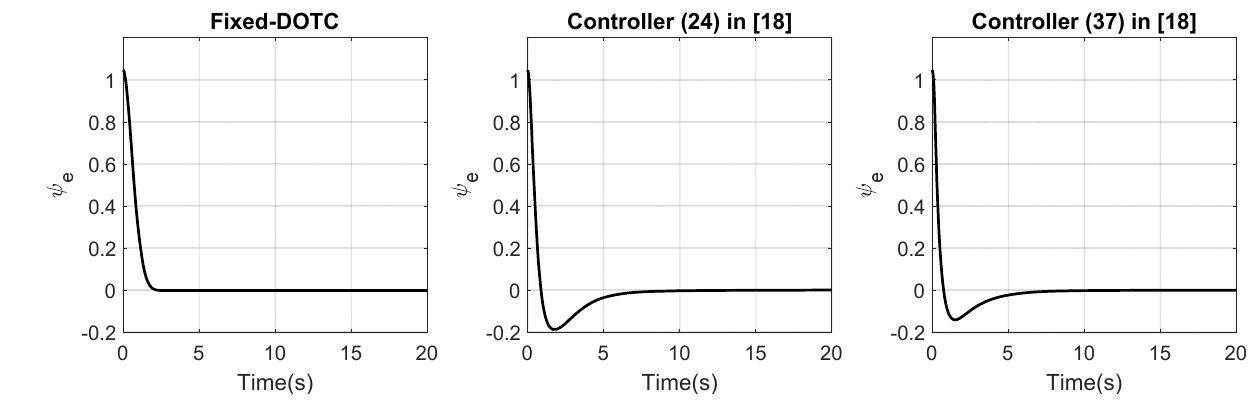
Figure 7. The orientation tracking error in part 1.